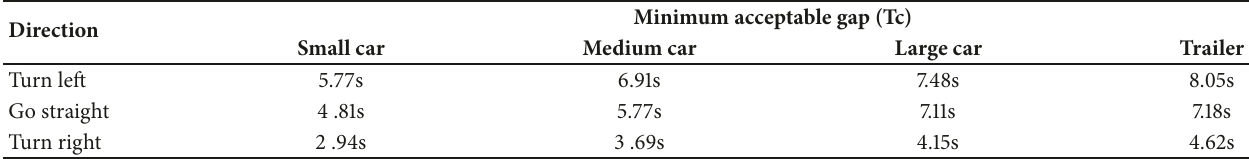
Table 1: Minimum acceptable gap for vehicles through an